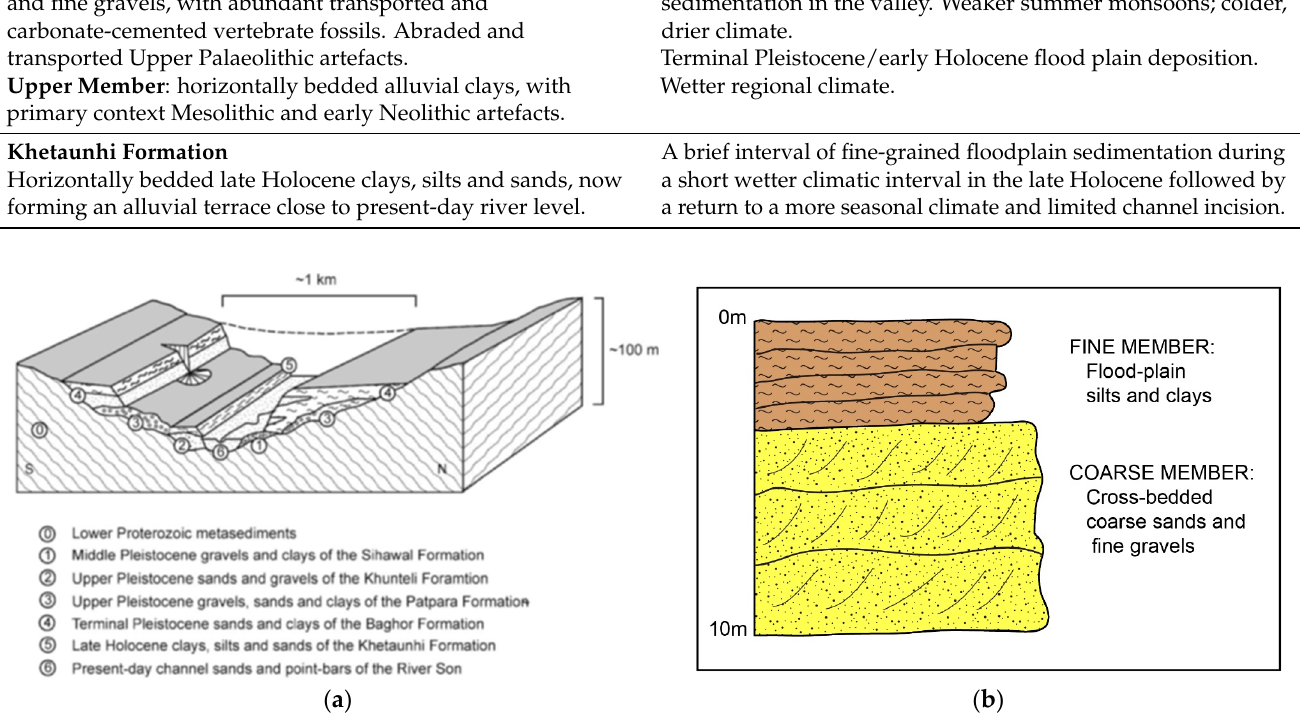
Figure 8. ( a ) Block diagram showing the five major alluvial formations investigated by the author in the Middle Son valley. (After [61] Figure 3 and [62] Figure 2). ( b ) Schematic section of the Baghor Formation in the Middle Son valley of north-central India showing the coarse-grained Lower Member and the fine-grained Upper Member. (For details, see [55,61]).